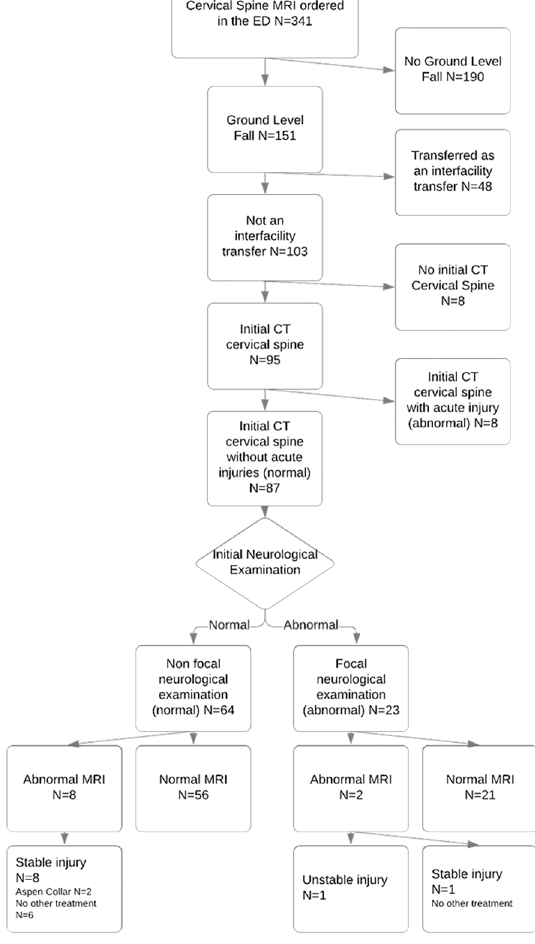
Figure 1. Flow diagram for chart